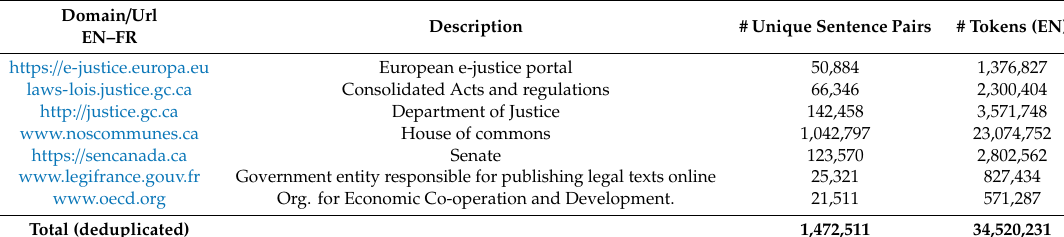
Table A2. Overview of the scraped corpus EN–FR on domain/url-level.